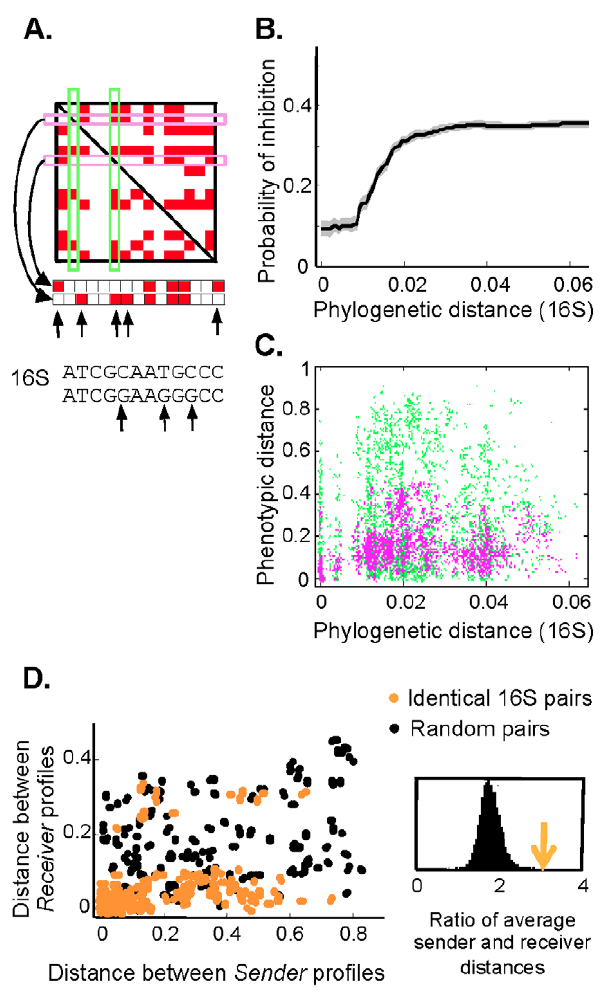
Figure 3. Sender profiles diverge faster than receiver profiles. (A) Distance between a pair of sender/receiver profiles is defined as the fraction of differing positions, and phylogenetic distance is proportional to the number of base pair differences in 16S rRNA. (B) Closely related isolates are less likely to inhibit each other. Plotted is the probability of inhibition for all pairs of isolates closer than a given 16S rRNA distance. (C) Number of 16S nucleotide differences ( x -axis) versus number of sender (green) and receiver (magenta) profile differences ( y -axis) for all isolate pairs. (D) The distance between sender profiles is plotted against the distance between receiver profiles for pairs with identical 16S rRNA (orange circles), and for pairs with identical randomized 16S (black circles). The randomization was done by permuting the assignments of the 16S sequences to isolates. There is an apparent tendency for sender profiles to diverge disproportionately more than receiver profiles for closely related strains. This is quantified in the inset, which displays the mean ratio of distances between sender and receiver profiles for pairs with identical 16S (orange arrow) and the corresponding distribution obtained by randomly permuting the assignments of 16S sequences to isolates (black histogram); p , 10 2 4 . We imposed simple non-spatial ecological dynamics that implicitly incorporates the importance of spatial relations between bacteria over short time scales (the antibiotics stay near their producers). The fitness of each strain depends on the weighted sum of its interactions with all other strains, incorporating the following contributions: (i) a negative effect of being inhibited by others, (ii) an advantage of inhibiting others, and (iii) a reduced ability to